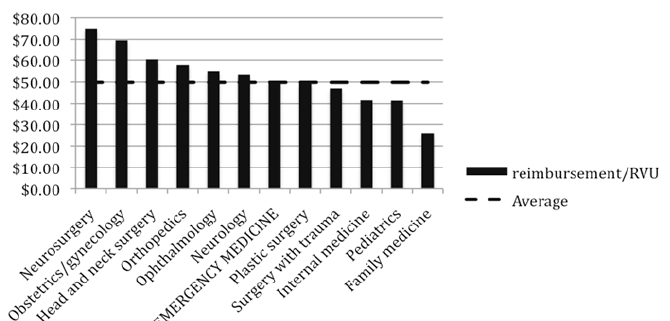
Figure 2. Reimbursement per relative value unit (RVU) for higher level of care (HLOC) transfer patients for 12 specialties. Average reimbursement per RVU for all specialites =